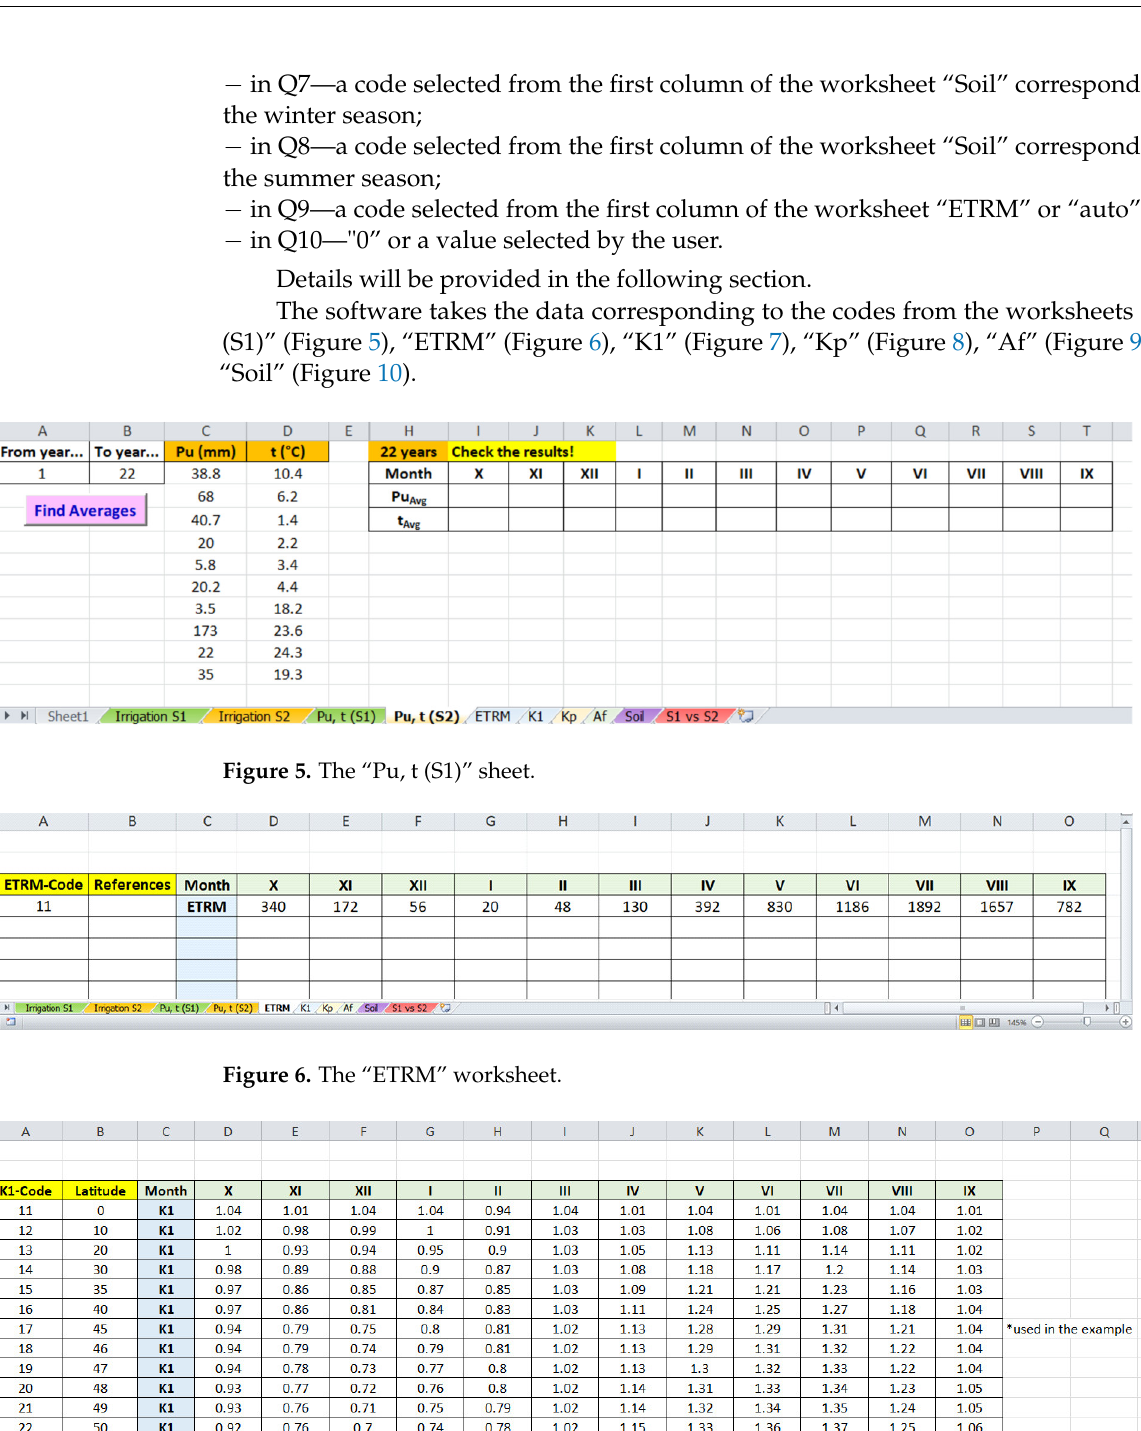
Figure 6. The “ETRM” worksheet. Figure 7. The “K1” worksheet. Data are taken from [34] and [47]. Figure 7. The “K1” worksheet. Data are taken from [34] and [47]. Figure 7. The “K1” worksheet. Data are taken from